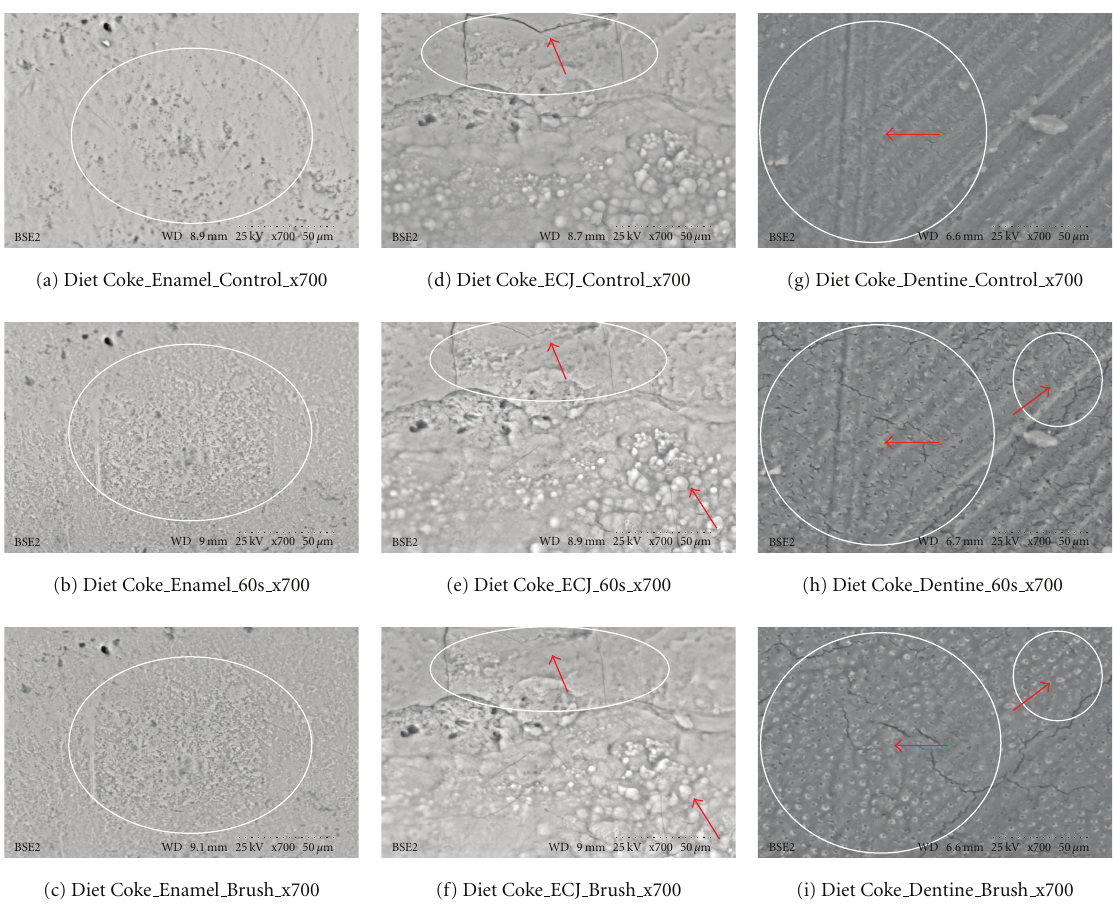
Figure 9: Diet Coke ( × 700). Outlined areas show erosion with minor surface changes from calcium loss when comparing (a), (d), and (g) to (b), (e), and (h). Minimal abrasionis is present on the enamel, but red arrows from brush abrasion are clearly (i). Red arrows show dentine tubules exposed from erosion appear clearer, wider, and more open as the soft surface material is lost to brush abrasion. These SEM results are also consistent with the calcium dissolution from swishes in Figure